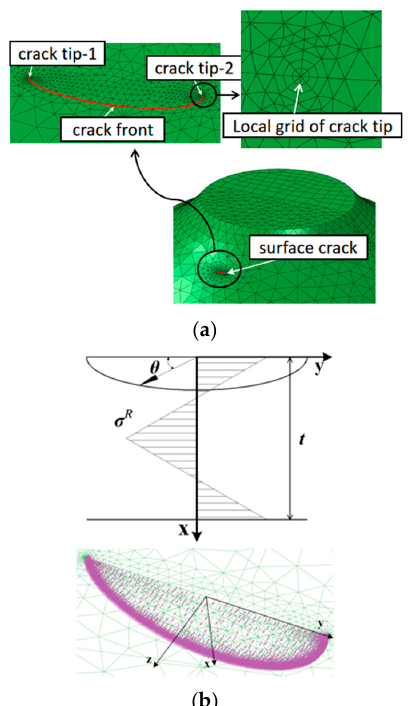
Figure 13. ( a ) The location and meshing of the introduced crack; ( b ) the distribution of residual stresses on crack surface [57].